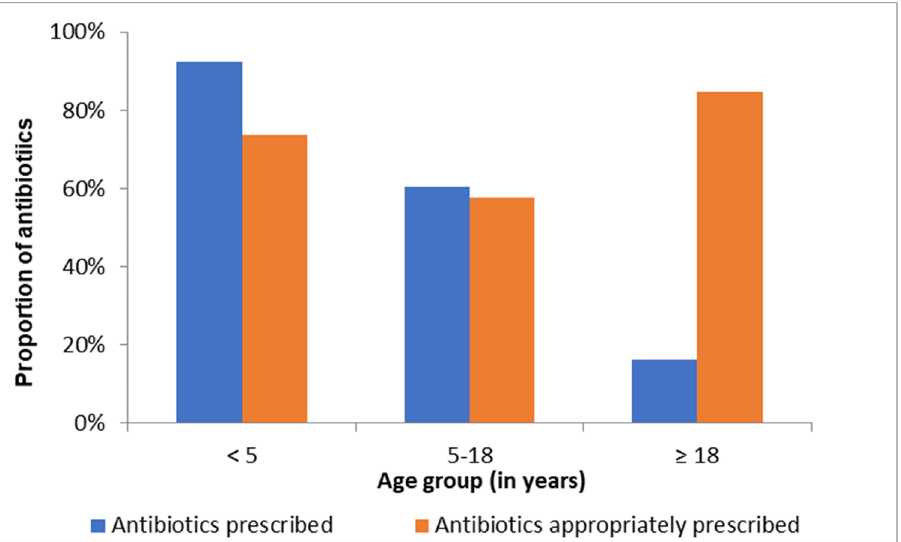
Figure 3. Proportions of antibiotics prescribed per age group.